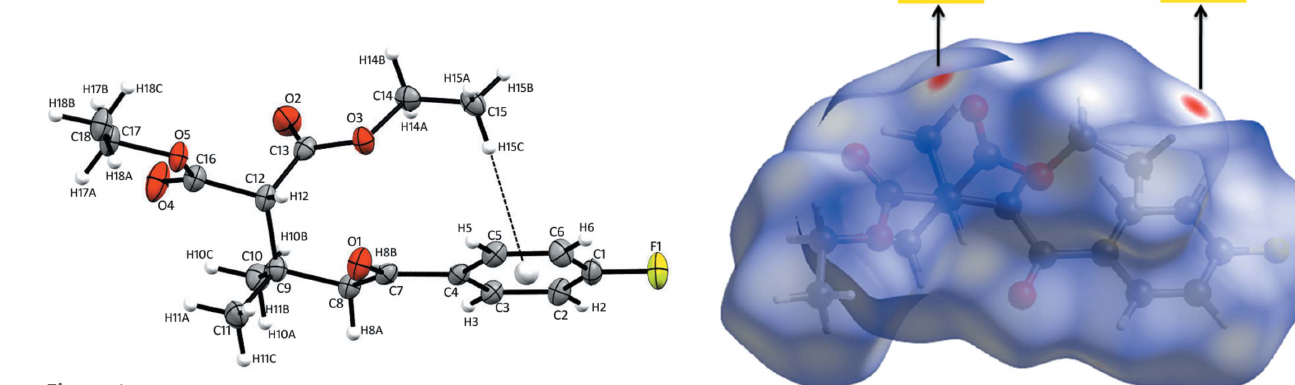
Figure 1 The asymmetric unit of the title compound with 50% probability ellipsoids with atom labelling. The intramolecular C—H (cid:2)(cid:2)(cid:2) (cid:2) interaction is shown as a dotted